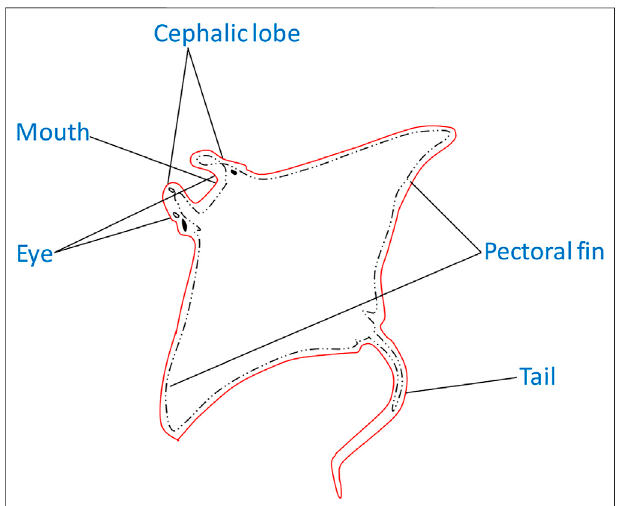
FIGURE 2 | Simpli fi ed anatomy of a